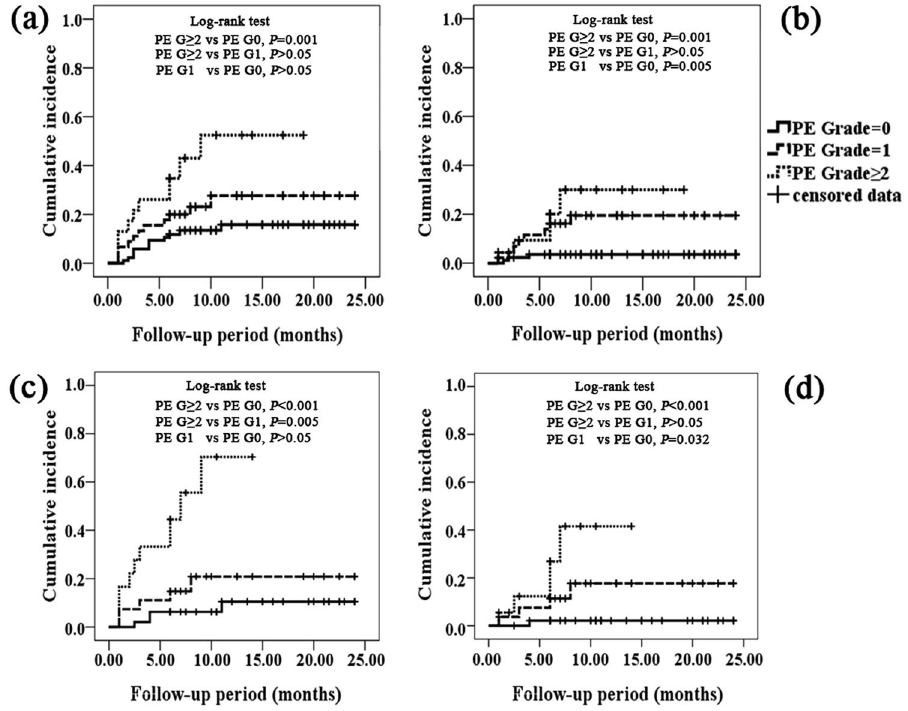
Figure 4. The cumulative incidence of radiation pneumonitis (RP) stratified by pulmonary emphysema (PE). ( a ) The cumulative incidence of Grade ≥ 2 RP in non-small cell lung cancer (NSCLC); ( b ) the cumulative incidence of Grade ≥ 3 RP in NSCLC; ( c ) the cumulative incidence of Grade ≥ 2 RP in squamous cell carcinoma (SCC); ( b ) the cumulative incidence of Grade ≥ 3 RP in